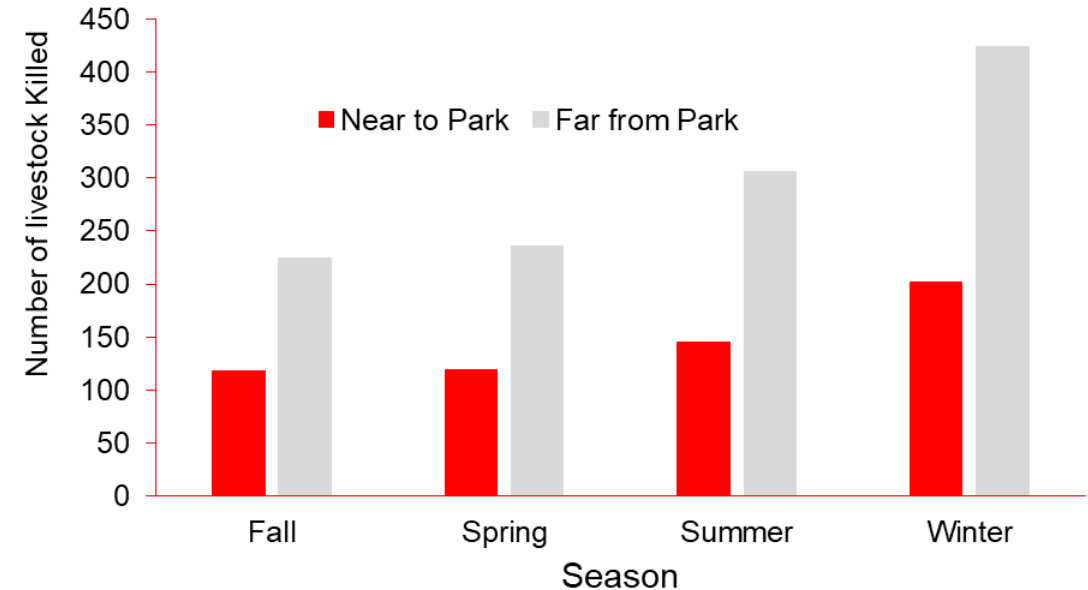
Figure 3. Number of livestock depredations occurring seasonally near (<1 km) and far from Bardia National Park (>1 km), Nepal, 2015–2019.